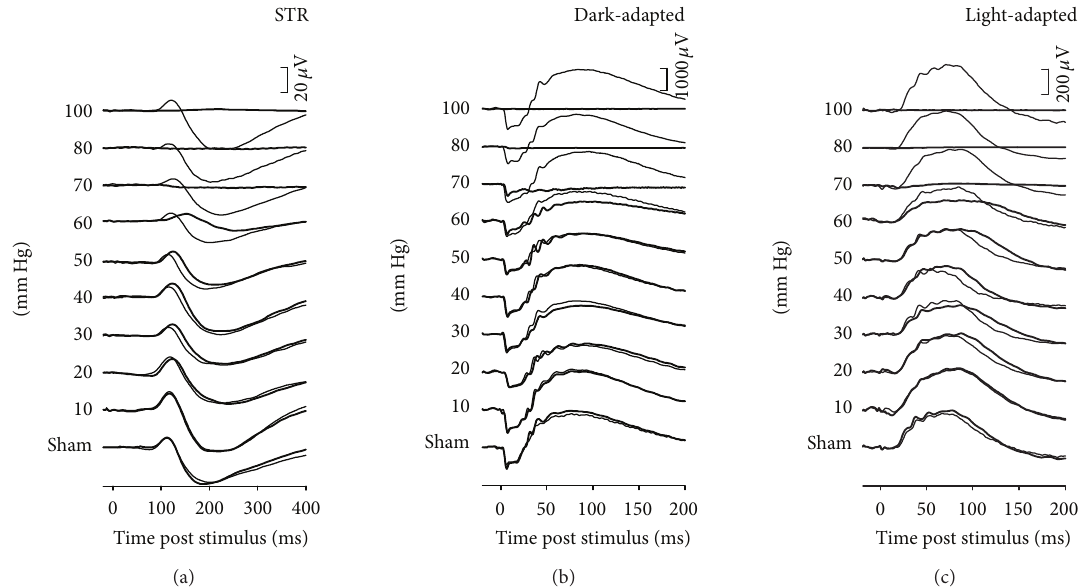
F 3: Rat ERG response to various levels of acute IOP elevation. (a) Scotopic threshold response (STR, bright �ash ERG (2.22logcdsm fellow control eyes are shown by the thin traces in each column. Reprinted from [46] with permission. e Association for Research in Vision and Ophthalmology remains the copyright